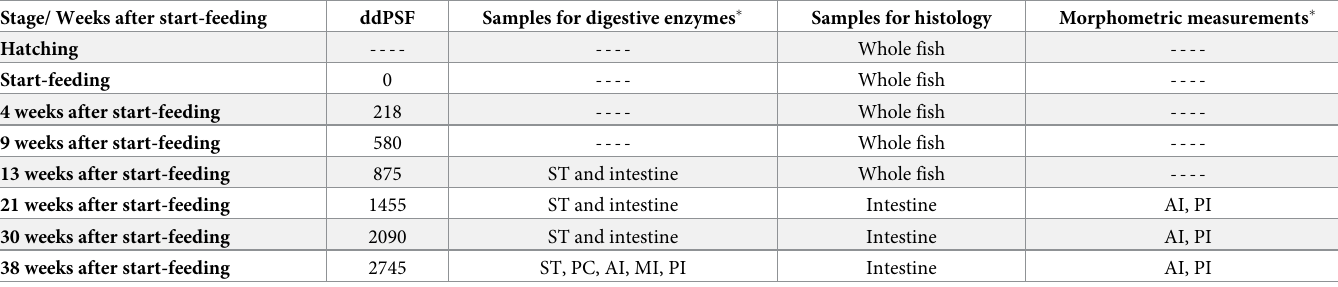
Table 1. Sampling times given in weeks and degree-days post start-feeding